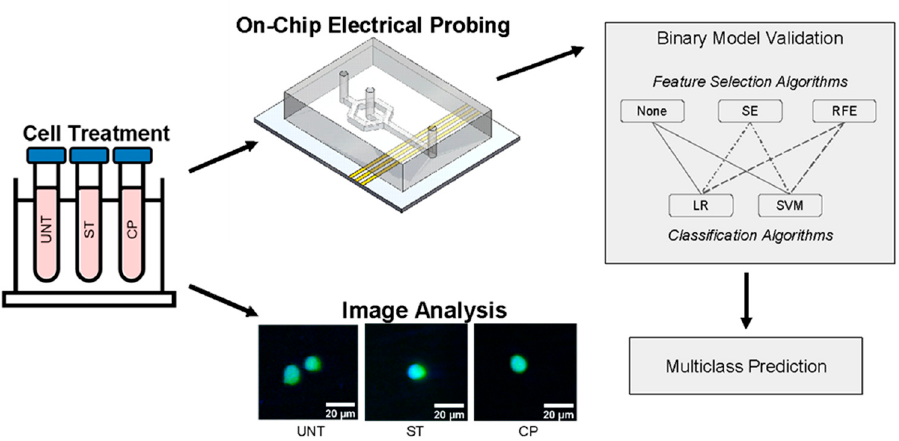
Figure 1. Experimental structure overview demonstrating both data collection and application of the ML paradigm of dual normalization, feature selection, and classification.